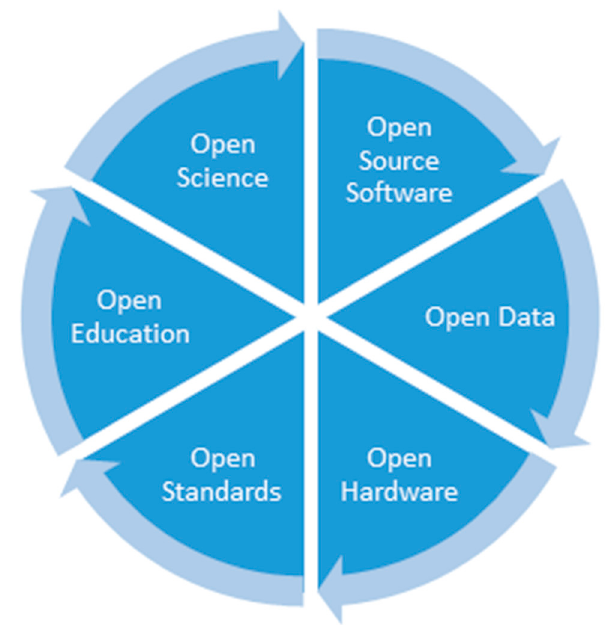
Figure 1. The many components of openness.